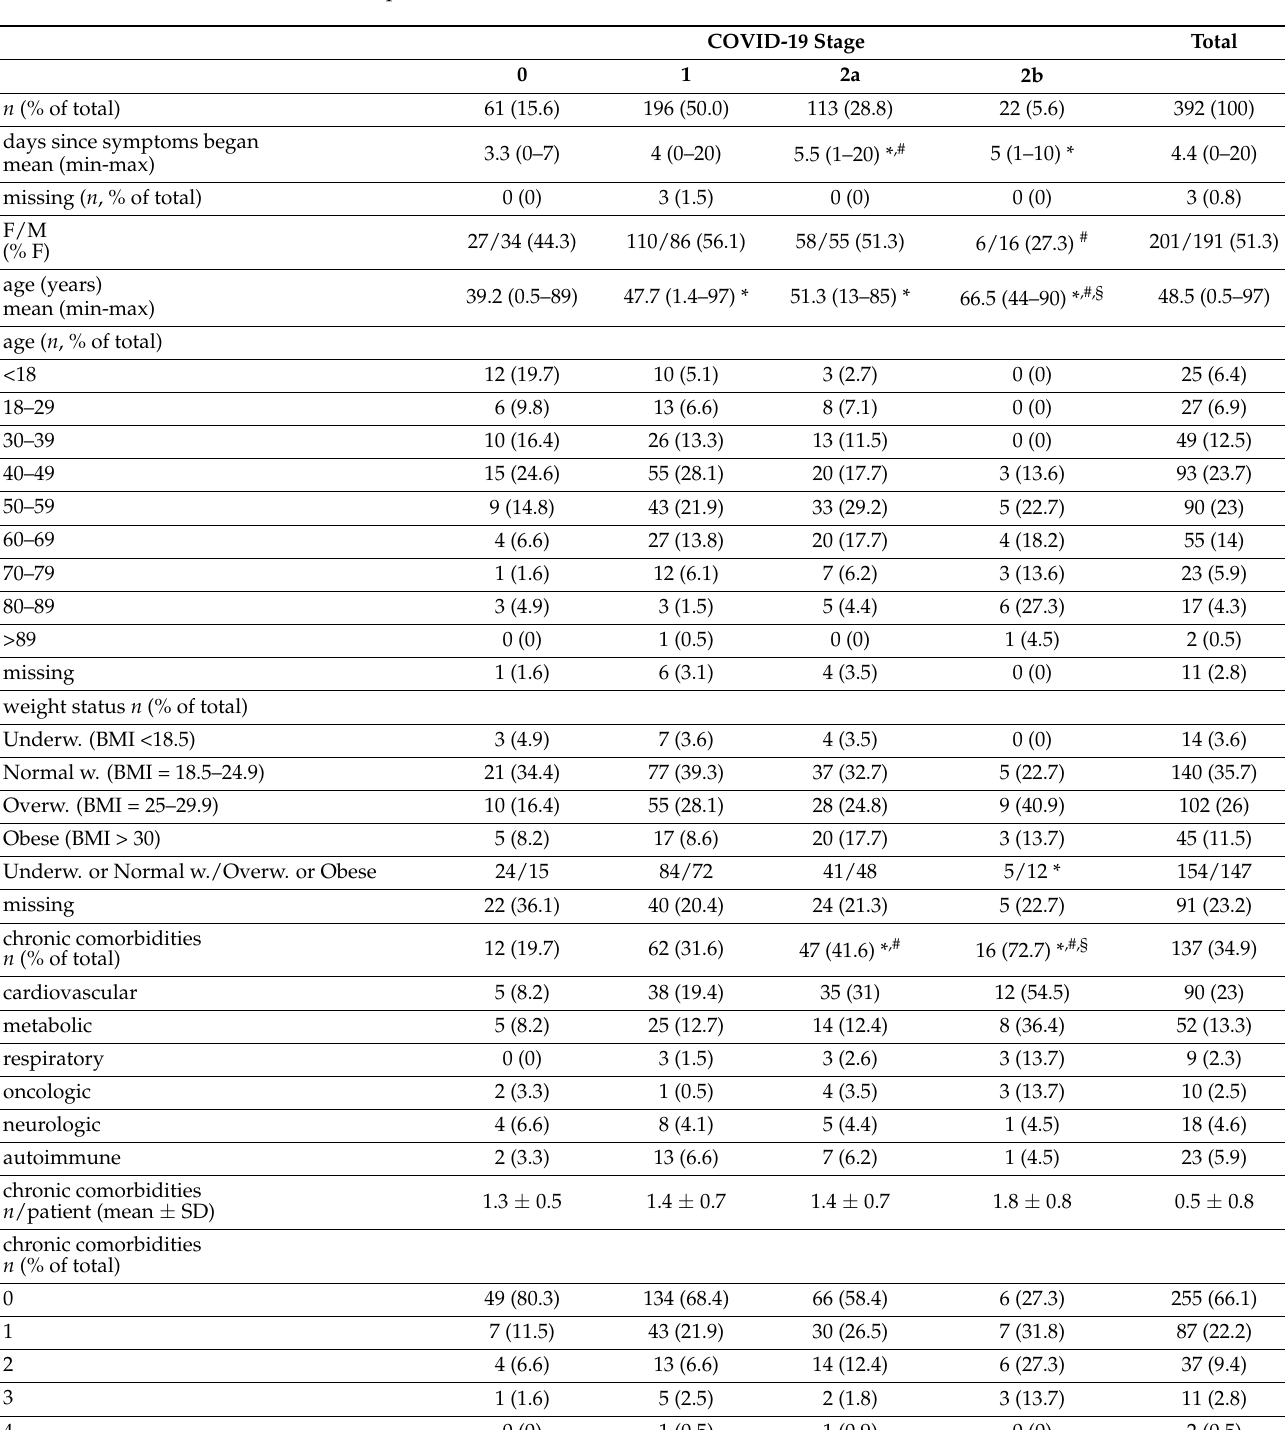
Table 1. Characteristics of COVID-19 patients included in the study according to disease stage when care of patients